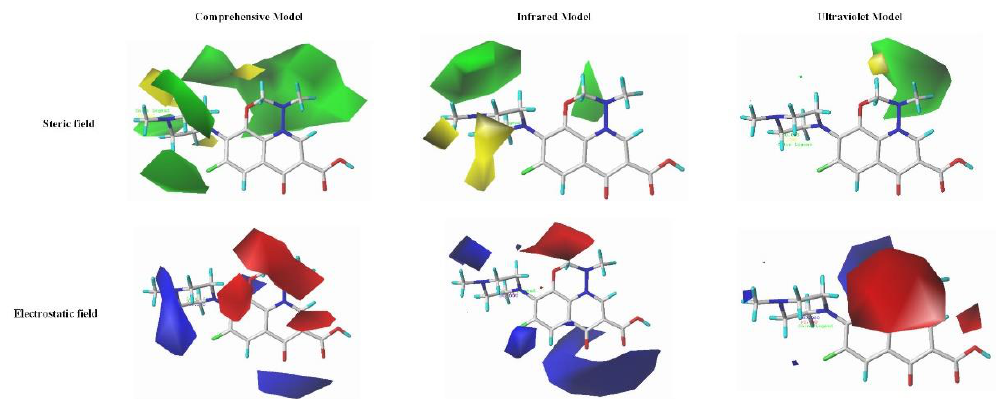
Figure 3. The contour maps of combined effect model and single effect model of infrared and ultraviolet spectra of marbofloxacin.